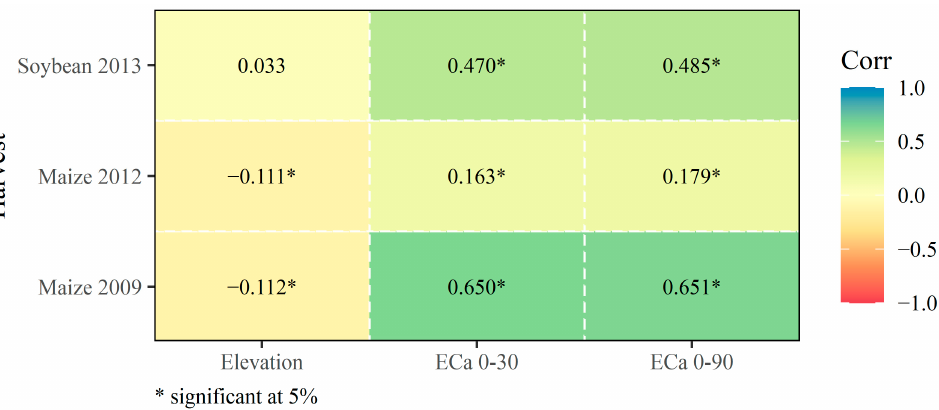
Figure 4. Correlograms for the variables used to delimit the management zones. A good correlation between soil ECa and crop yield has also been observed in different studies [24]. According to Molin et al. [25] and Uribeetxebarria et al. [26], ECa has been used as a proxy for soil water content, soil density and texture, organic matter content, salinity, cation exchange capacity, among other characteristics that may be difficult to measure in the field. Therefore, this layer presents a potential to be used in the planning of varied rate seeding, adjusting this for each environment. In parallel, soil fertility data may also contribute to the understanding of causes for the spatial variability evidenced by